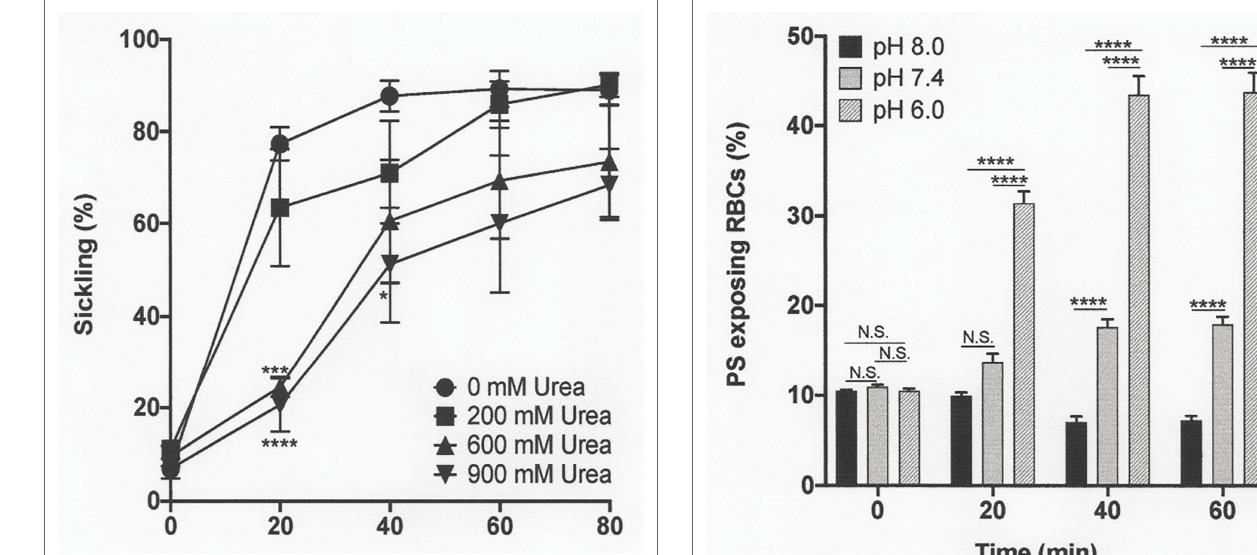
FIGURE 5 | The effect pH on phosphatidylserine exposure in deoxygenated red cells from patients with SCA. Red cells (1% Hct) were incubated in Eschweiler tonometers at 37 o C and an osmolality of 290 mOsm.kg-1 for up to 60 min under fully deoxygenated (0 mmHg oxygen) conditions. At the time intervals indicated, red cell aliquots were removed and PS exposure measured using LA-FITC, as described in the Methods. Histograms represent means ± SEM, n = 3. N.S: not significant; **** p <